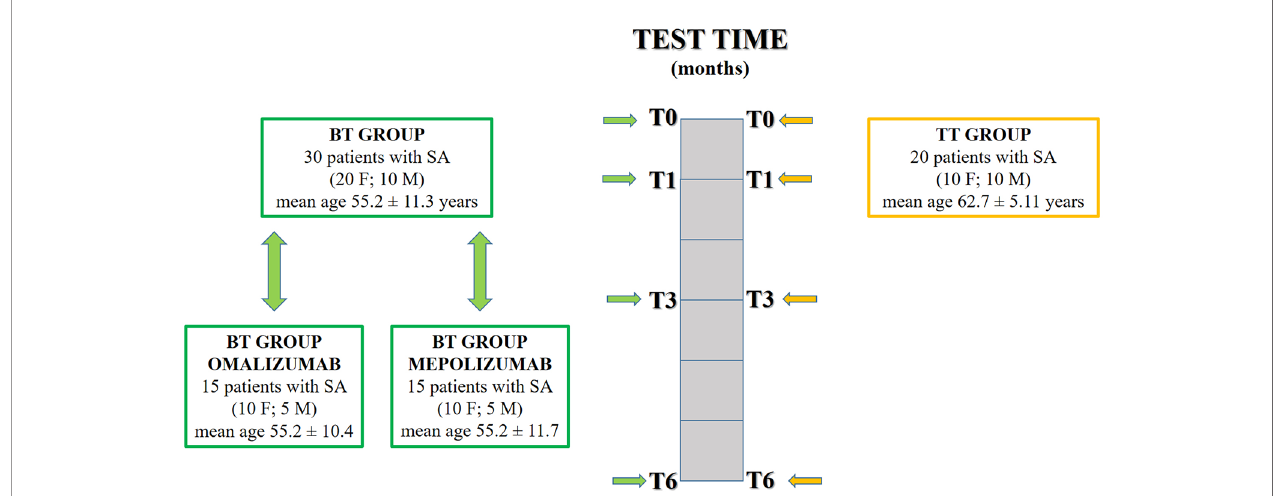
FIGURE 1 | Two groups were enrolled: biological treatment group (BT group) and traditional treatment group (TT group). The BT group was further subdivided under drug criteria: omalizumab group and mepolizumab group. All groups were tested at different times: T0 ( fi rst administration of the biologic agent); T1 (after 1 month); T3 (after 3 months); T6 (after 6